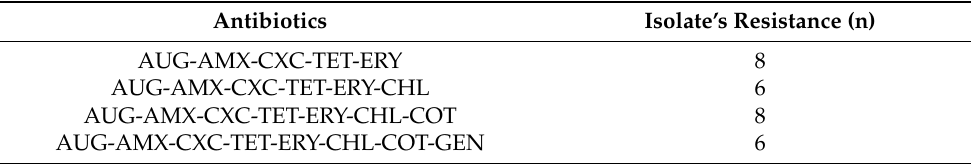
Table 1. Multidrug resistance of S. aureus isolates in raw chicken meat samples.